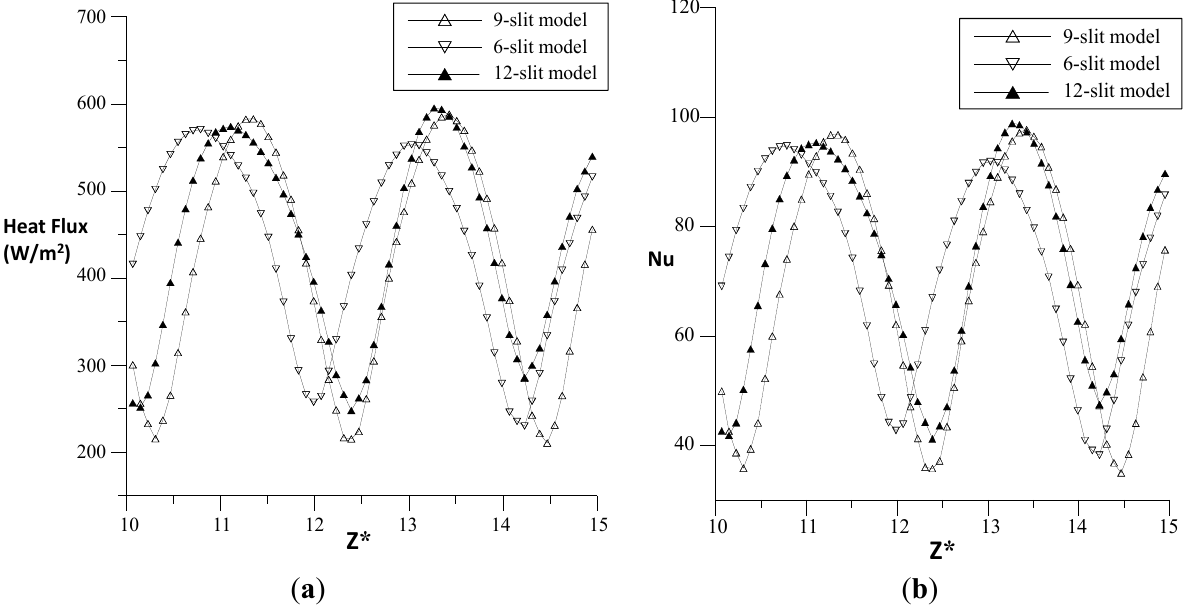
Figure 19. Heat flux and Nusselt number along axial direction in different slit models. ( a ) Heat flux distribution; and ( b ) Nusselt number